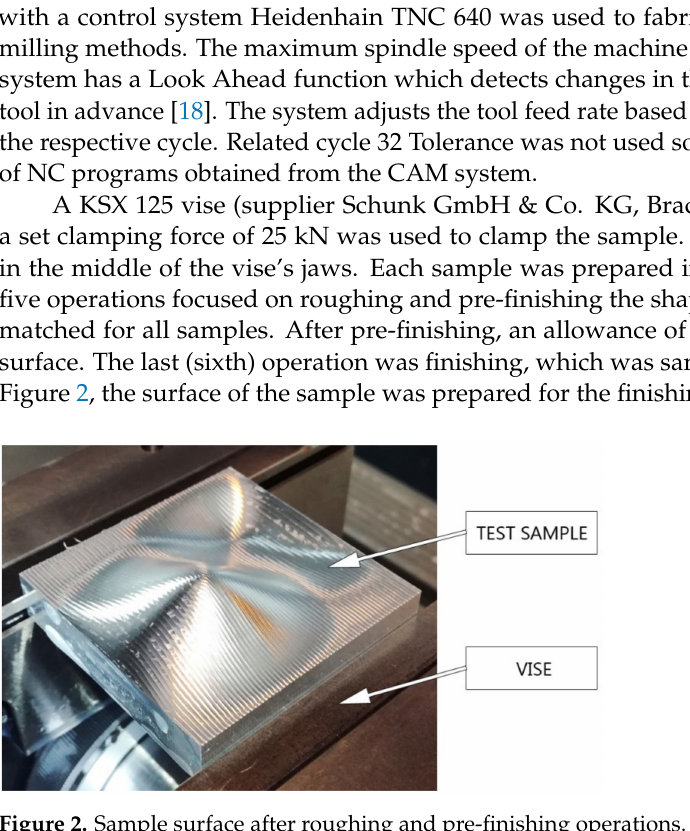
Figure 2. Sample surface after roughing and pre-finishing